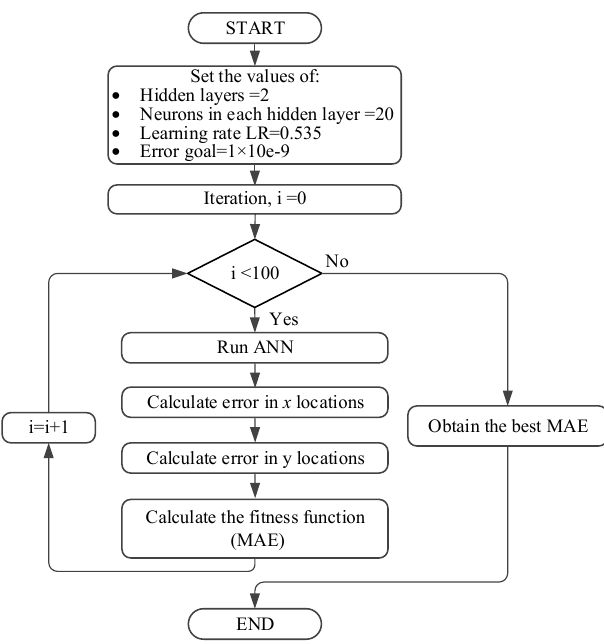
Figure 11. Flow diagram of ANN.